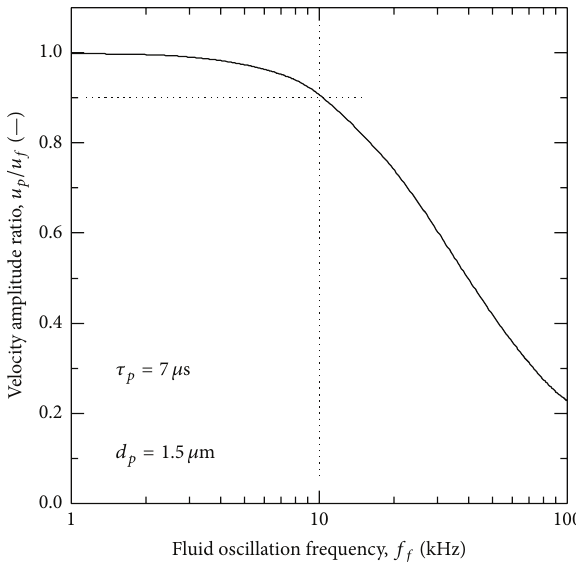
Figure 5: Velocity amplitude ratio between particle and fluid motion as a function of fluid motion